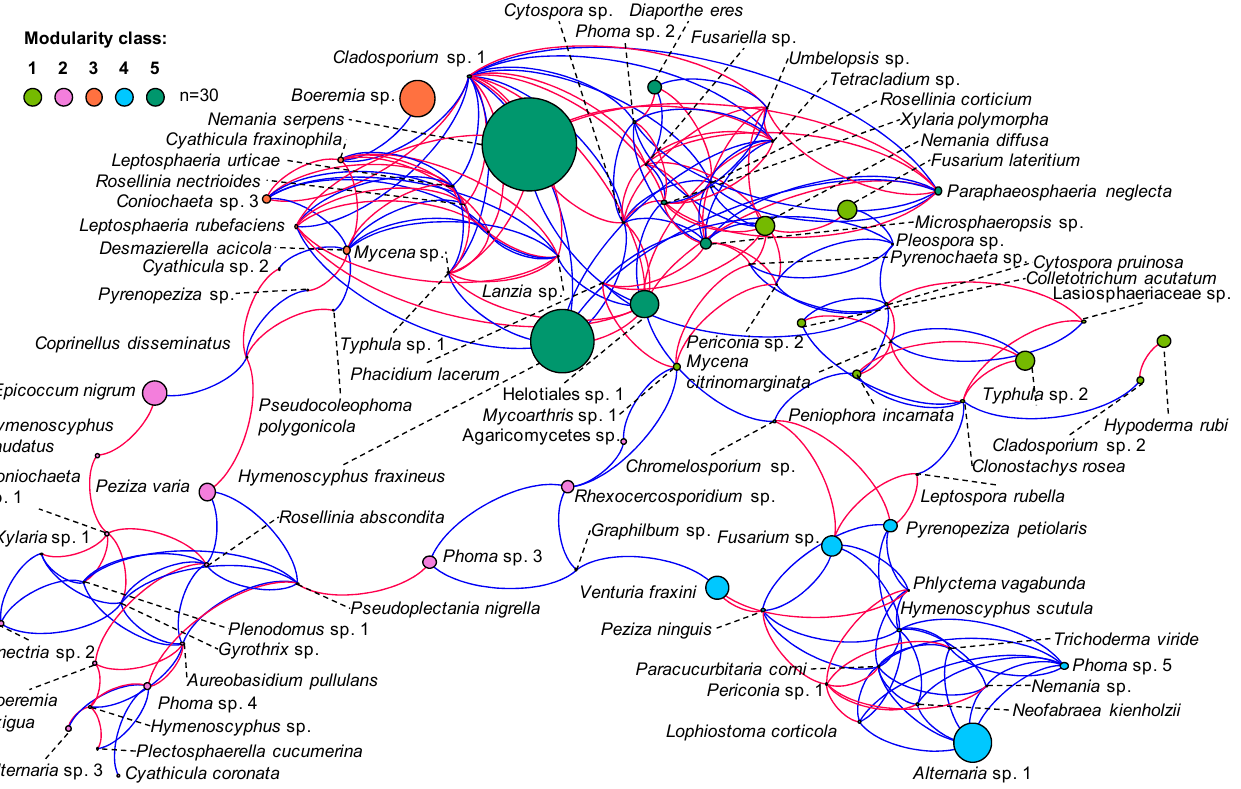
Figure 4. Network of co-occurrence of fungi isolated from the previous year’s leaf petioles of F. excelsior in five stands, in southern Poland, determined on the basis of data grouped for the study plots. Each connection shows a strong (Spearman’s p > 0.6) and significant ( p < 0.05) correlation. Blue lines indicate positive and red lines negative correlation. Five modules were generated, and the same color represents fungal taxa with potential co-occurrence in the same module. The frequency of the species was indicated by the size of each node.